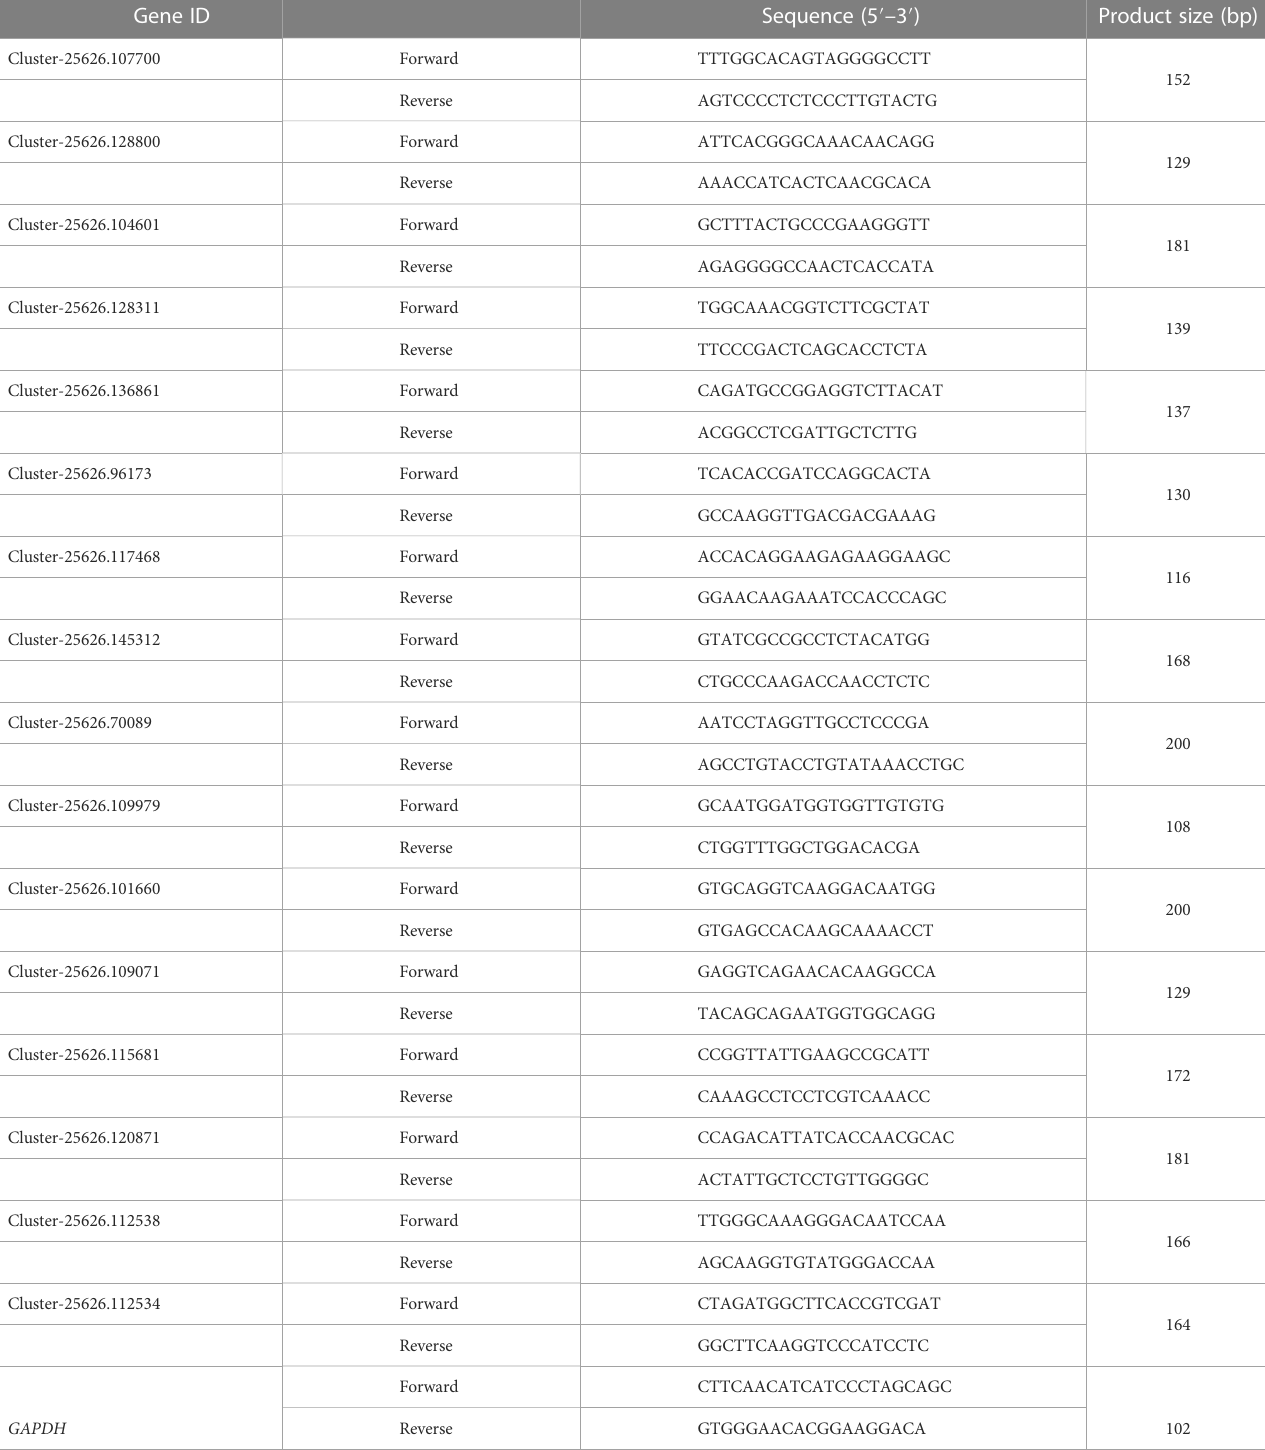
TABLE 1 Primers selected for real-time quantitative polymerase chain reaction (qRT-PCR)